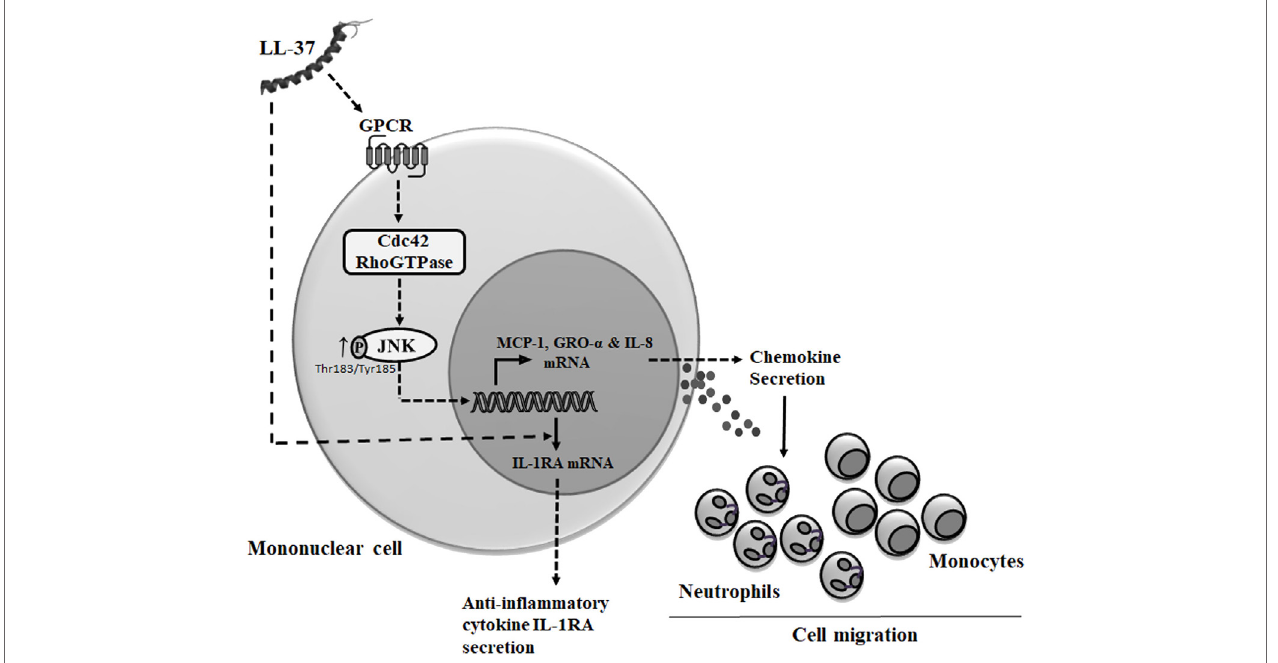
FigUre 10 | Model describing mechanism of LL-37-mediated chemokine secretion and leukocyte recruitment. Based on results from this study and previous studies, we propose that LL-37 can interact with G protein-coupled receptor (GPCR) to further activate ( → ) Cdc42 Rho GTPase (8, 11), resulting in enhanced phosphorylation of JNK mitogen-activated protein kinase (MAPK) (T183/Y185). The LL-37-GPCR-Cdc42 RhoGTPase axis signals via the JNK MAPK pathway to induce the production of chemokines and promote leukocyte migration. Alternatively, intracellular uptake of LL-37 may be mediated by other receptors (37) or using mechanisms similar to cell-penetrating peptides involving the cytoskeletal machinery (62). LL-37-induced anti-inflammatory cytokine IL-1RA production is independent of both GPCR and Cdc42/Rac1 Rho